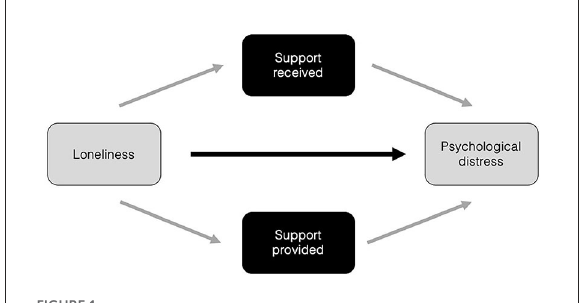
FIGURE1 Hypothesized model showing the relationship between loneliness and psychological distress as mediated through both support received, and support